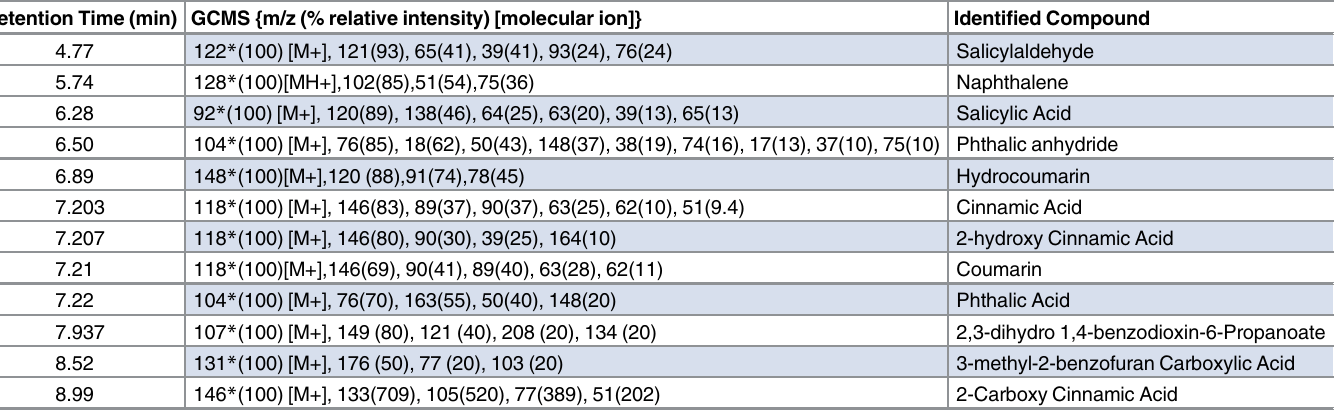
Table 3. Metabolic intermediates detected by GCMS over a 7-day growth period of R . opacus strain M213 when grown on 0.5% Naphthalene as the sole source of carbon and